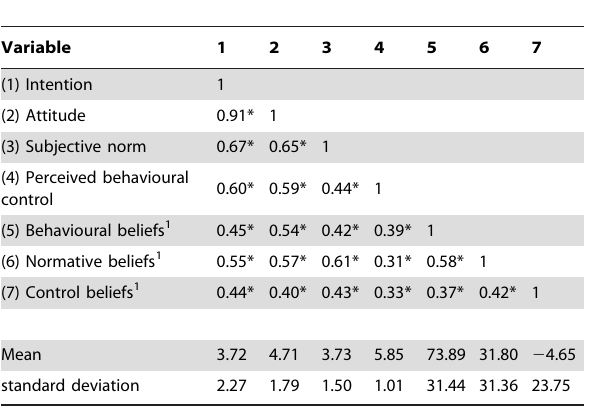
Table 1. Means, standard deviations and correlations of intention with the theory of planned behaviour direct constructs (attitude, subjective norm and perceived behavioural control) and the respective underlying behavioural, normative and control beliefs.